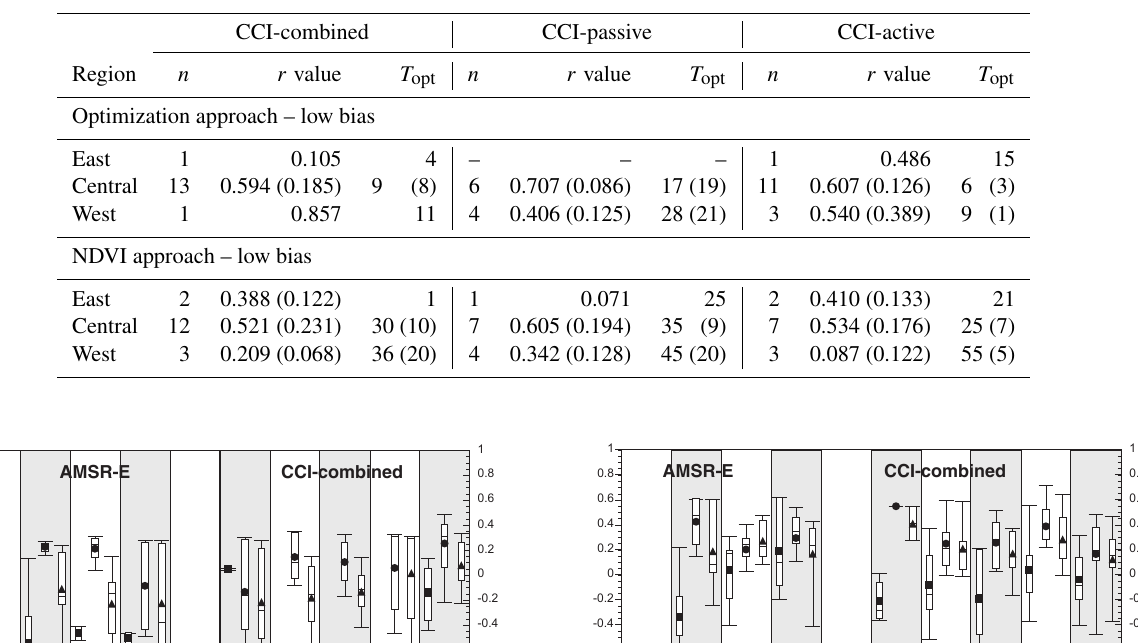
Table 6. Average lagged r values T opt between SWI based on optimization and in situ soil moisture at the 20cm depth for the USCRN network during era 5. Standard derivation is indicated in parentheses. Sites are divided by region (east, central, west) as indicated in Fig. 2. The n value represents the number of observations.